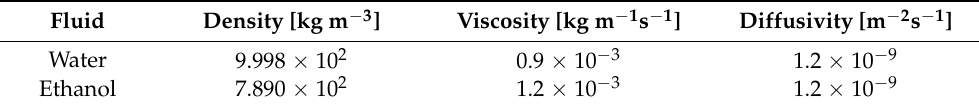
Table 1. Physical properties of the two considered working fluids at 293.15 K